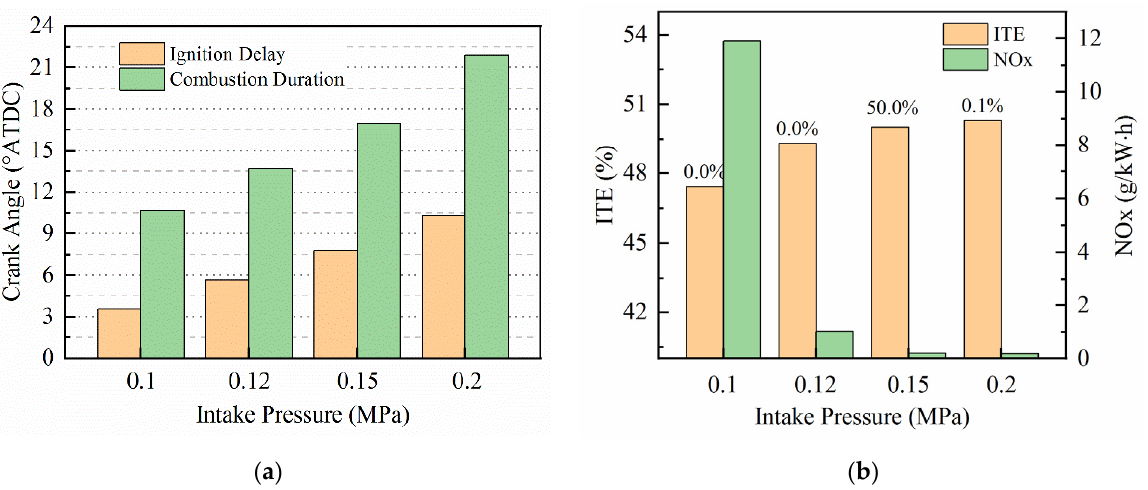
Figure 10. Ignition delay and combustion duration ( a ) and ITE and NOX emissions ( b ) for different intake pressures (hydrogen mass fixed) [48].